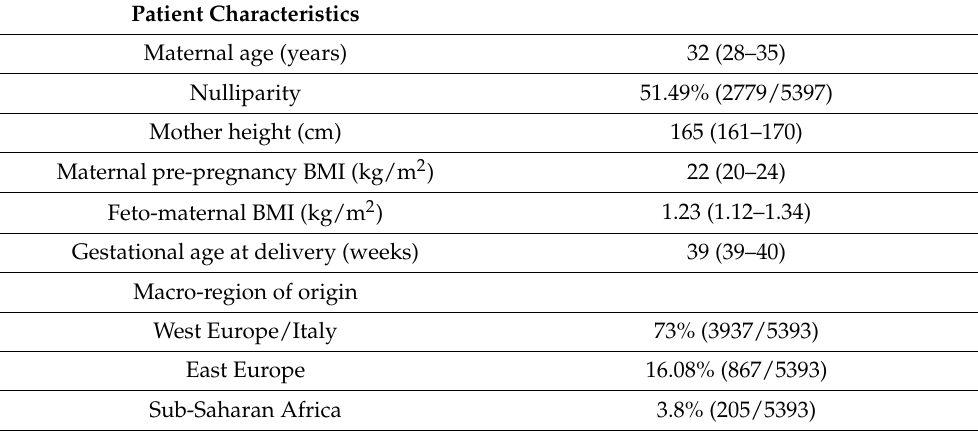
Figure 1. Panel ( A ), Flowchart of the study. Panel ( B ), ROC curves of the univariate and multivariate models. Table 1. Population